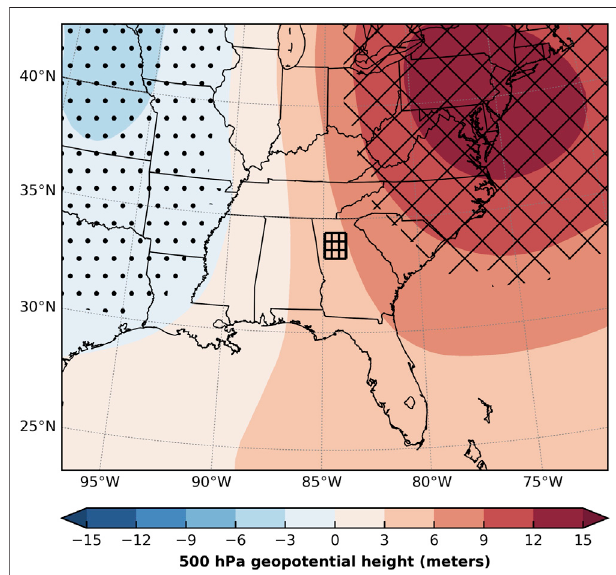
FIGURE3| Composite anomaly mapof500 hPageopotentialheightfor URDs comparedtonon-URDs.Crosshatching(dothatching)indicatesheight anomalies that are at least 1 standard deviation greater (lower) than the sample mean. The 9-cell gridded framework centered on Atlanta is indicated by the black-outlined